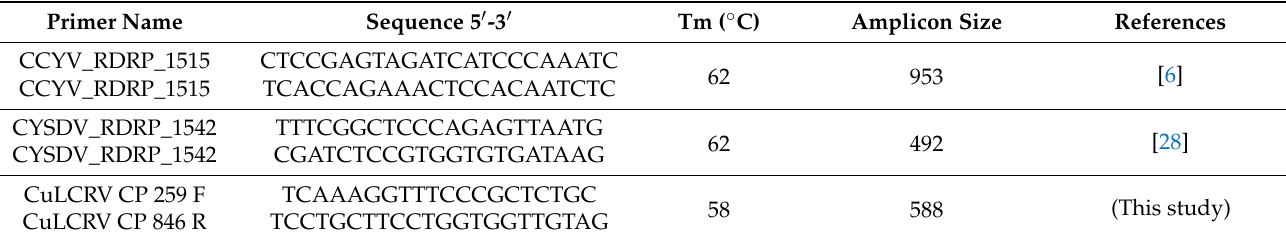
Table 1. Primers used for detection of viruses in this